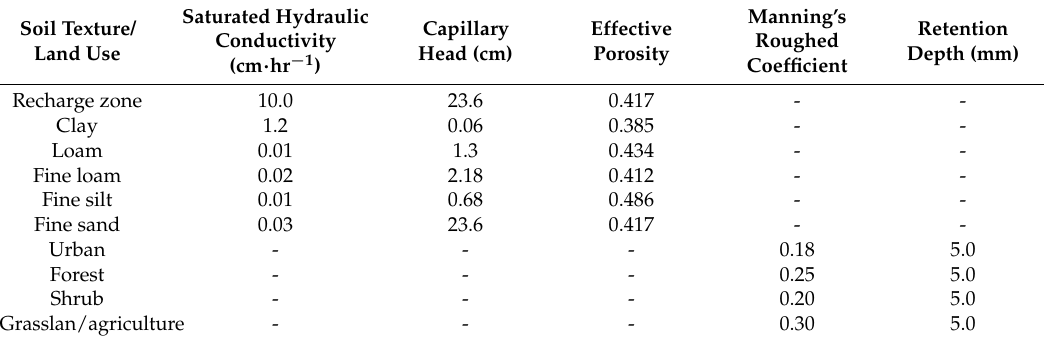
Table 2. Gridded Surface Subsurface Hydrologic Analysis (GSSHA) infiltration and overland flow parameters for the Blanco watershed